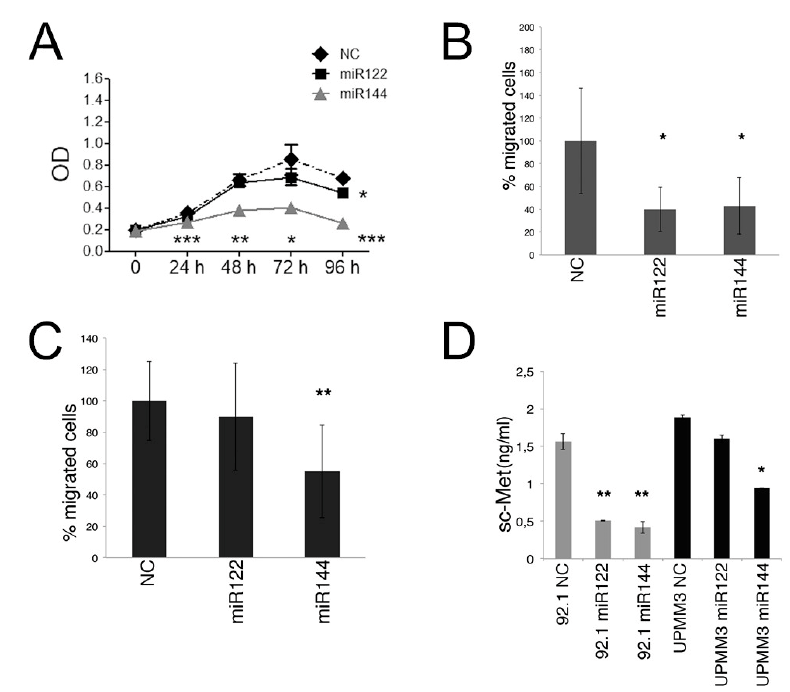
Figure 5. Effects of miR122 and miR144 mimic transfection on cell proliferation, migration and release of soluble c-Met. ( A ): proliferation, detected by a 3-(4,5-dimethylthiazol-2-yl)-2, 5-diphenyl tetrazolium bromide (MTT) assay, is significantly reduced in 92.1 cells transfected with miR122 and miR144 mimic. Data are expressed as mean ± sd of three different experiments. ( B ): migration assay shows a reduction of migrated 92.1 UM cells upon transfection with mimic miR122 or miR144, while migration of UPMM3 cells ( C ) is inhibited with mimic miR144. A representative experiment of three is shown. ( D ): transfection of mimic miR144 reduces soluble c-Met (sc-Met) levels in conditioned medium of the 92.1 and UPMM3 UM cell lines while miR122 affects soluble c-Met in 92.1 cells. Data are representative of three experiments (* p < 0.05; ** p < 0.01; *** p < 0.001).